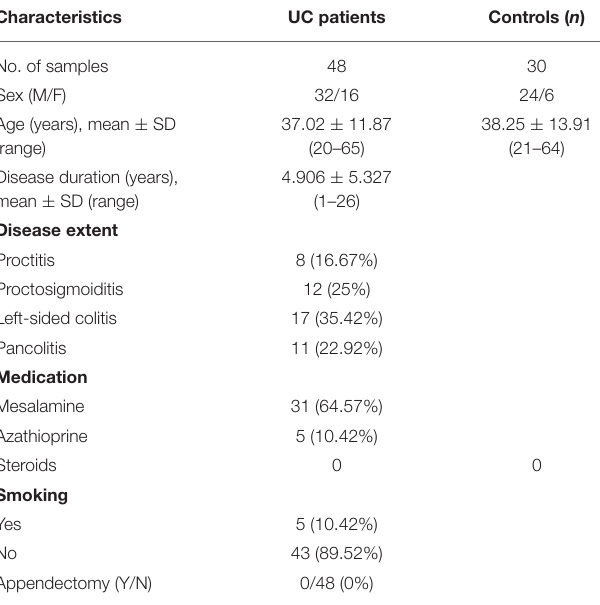
TABLE 1 | Demographic features of study subjects. TABLE 2 | Primers used for reverse transcription (RT) and qRT-PCR for miRNAs and qRT-PCR for target genes.